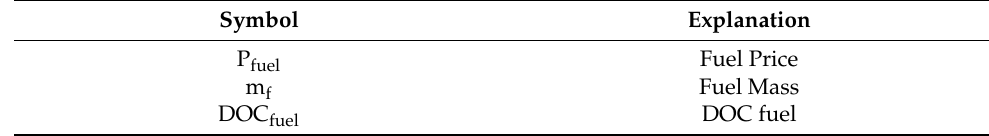
Table 4. Fuel cost symbols